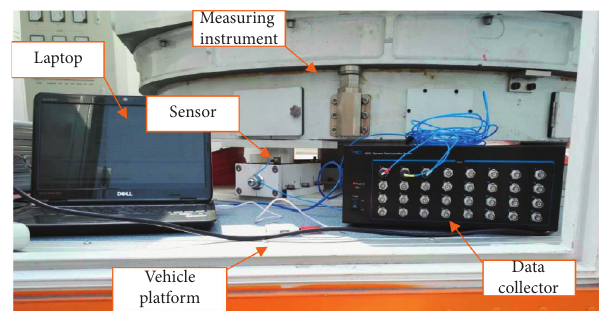
Figure 9: Apparatuses of vehicle platform vibration test.